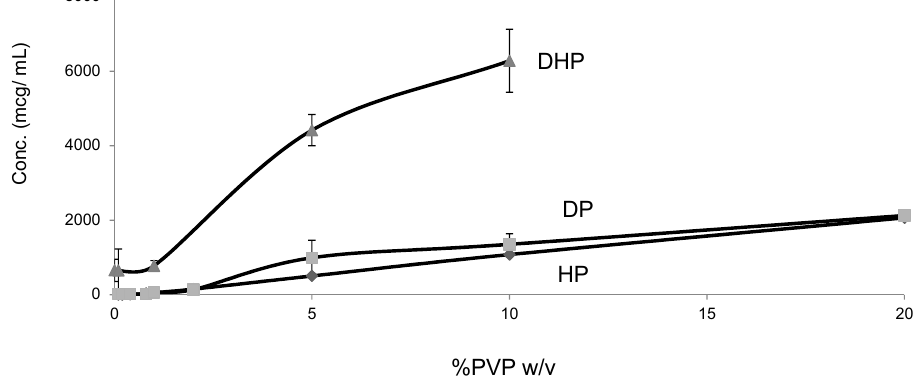
Figure 9. Equilibrium solubility of HP, DP and DHP at varying concentration of PVPK30 in water. The DP dissolution profiles show clear polymer concentration dependent solubility enhancement.